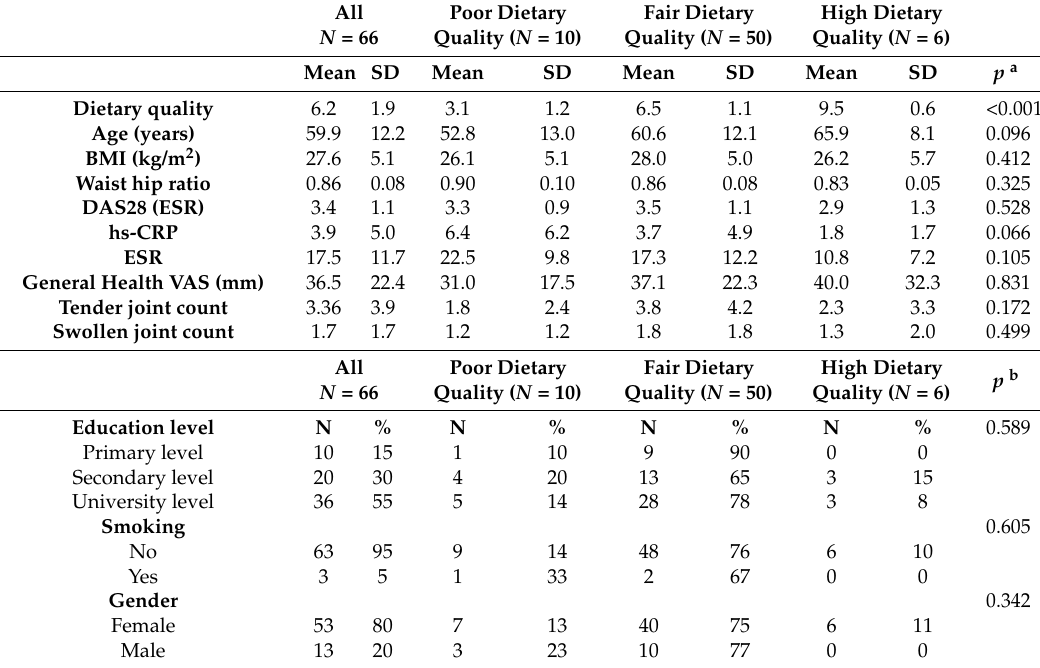
Table 1. Characteristics of the 66 Swedish patients with rheumatoid arthritis.